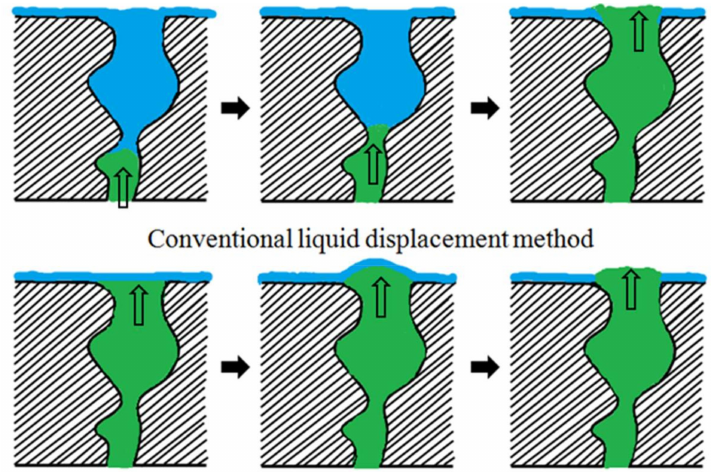
Figure 2. Schematic of the conventional and “modified” liquid–liquid displacement methods (Liquid A in blue, Liquid B in